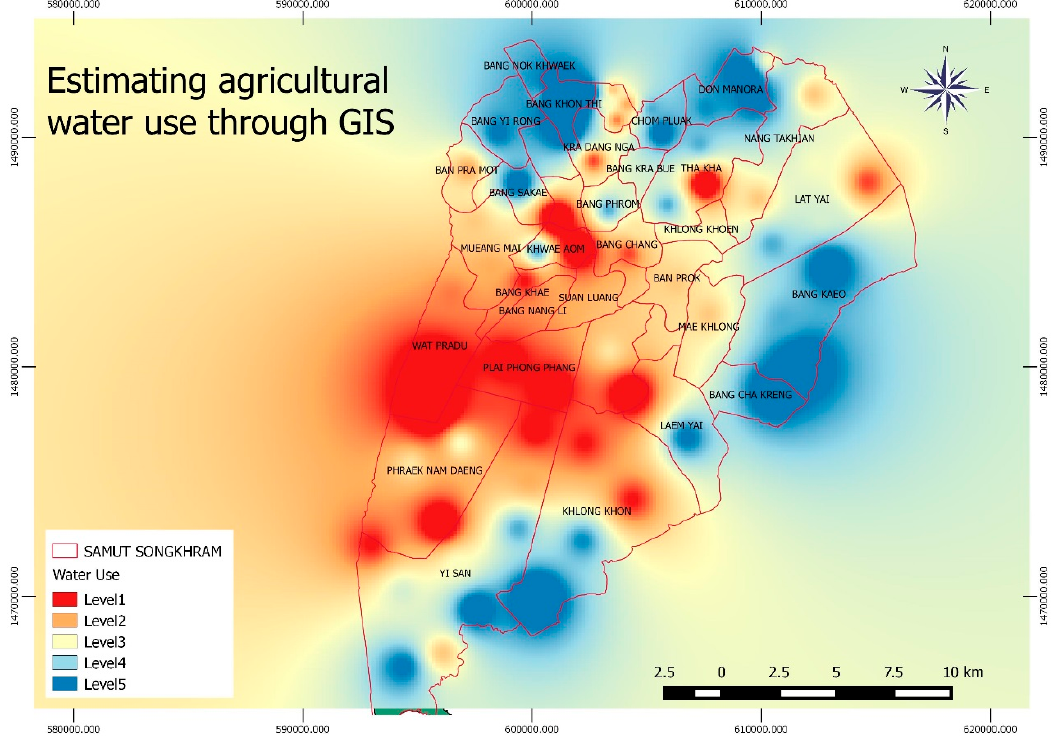
Figure 1. Water use levels in Samut Songkhram,